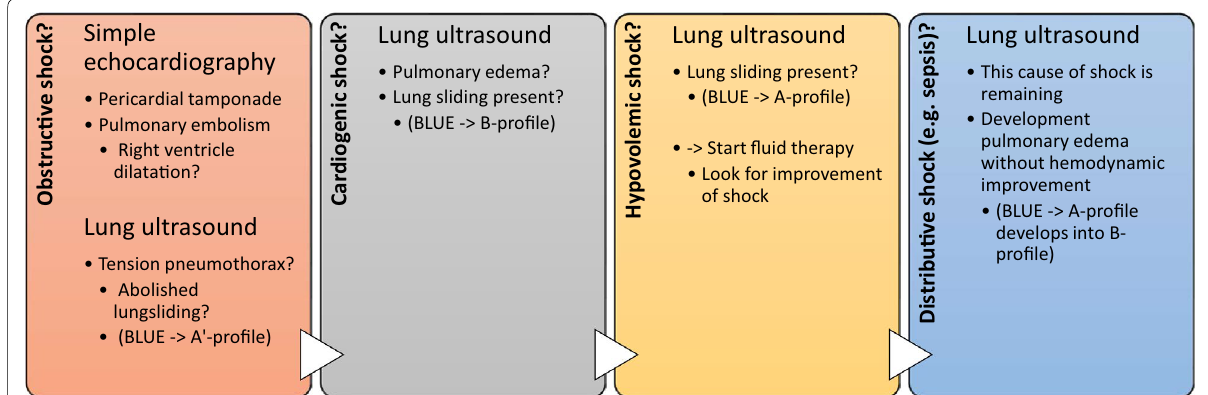
Fig. 6 FALLS protocol. This diagram is an adaptation of the work by Dr. Lichtenstein [39]. Firstly, this diagram shows the type of shock the focus is on. Secondly, the type of ultrasound examination is shown. Thirdly, possible diagnoses to consider are shown including their appearance in terms of the BLUE protocol. Every cause of shock is sequentially excluded for expediting the diagnosis of distributive (septic) shock. FALLS fluid administration limited by lung sonography, BLUE bedside lung ultrasound in emergency, BLUE and the A, B, and A’ profile are explained in Table 1, items 1, 2, and 8,